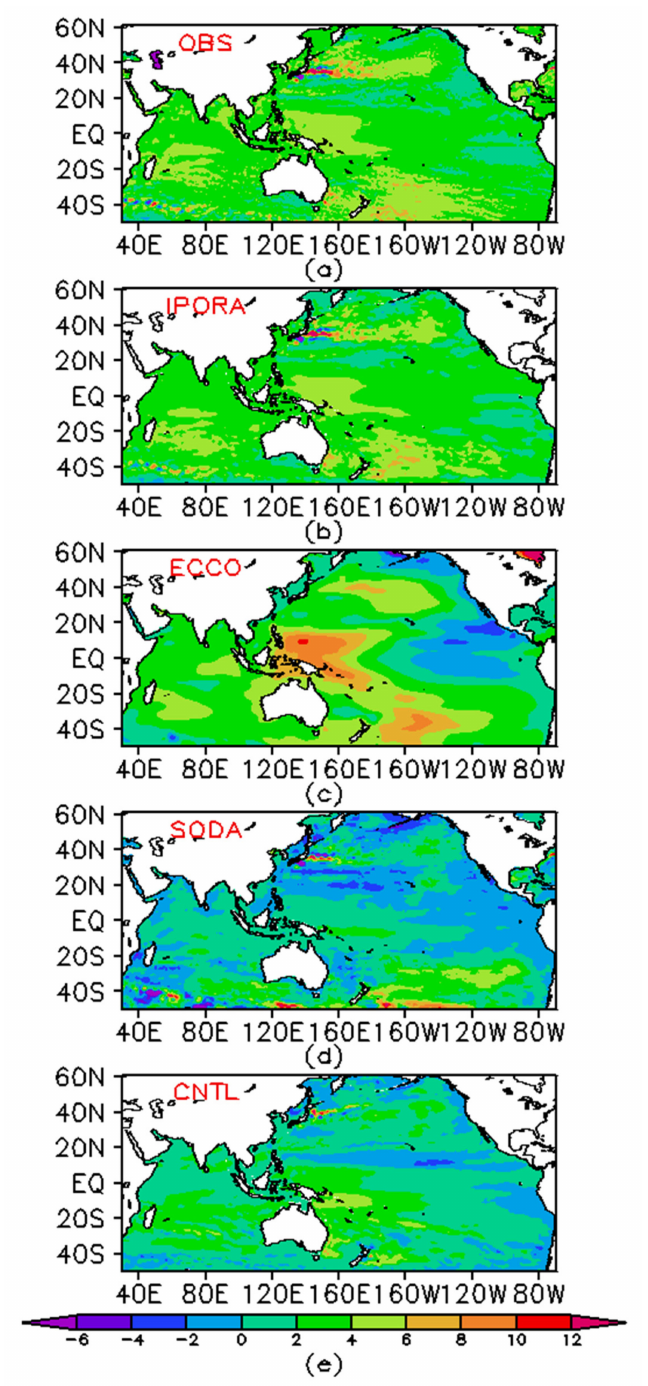
Figure 6. The linear trend (units: mm yr − 1 ) of SLA during the period of 1993–2020 in the Indian and Pacific oceans from ( a ) observations, ( b ) IPORA, ( c ) ECCO, ( d ) SODA, and ( e )